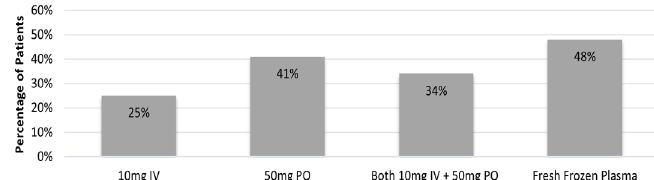
Figure 2. Thirty-eight patients presented and were identified as being exposed to tainted synthetic cannabinoids.